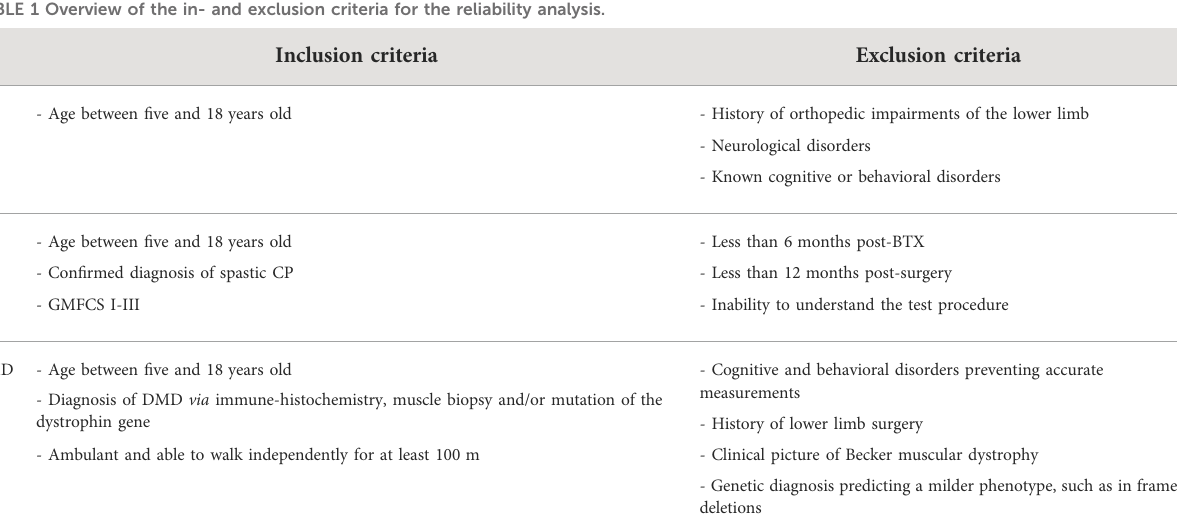
TABLE 1 Overview of the in- and exclusion criteria for the reliability